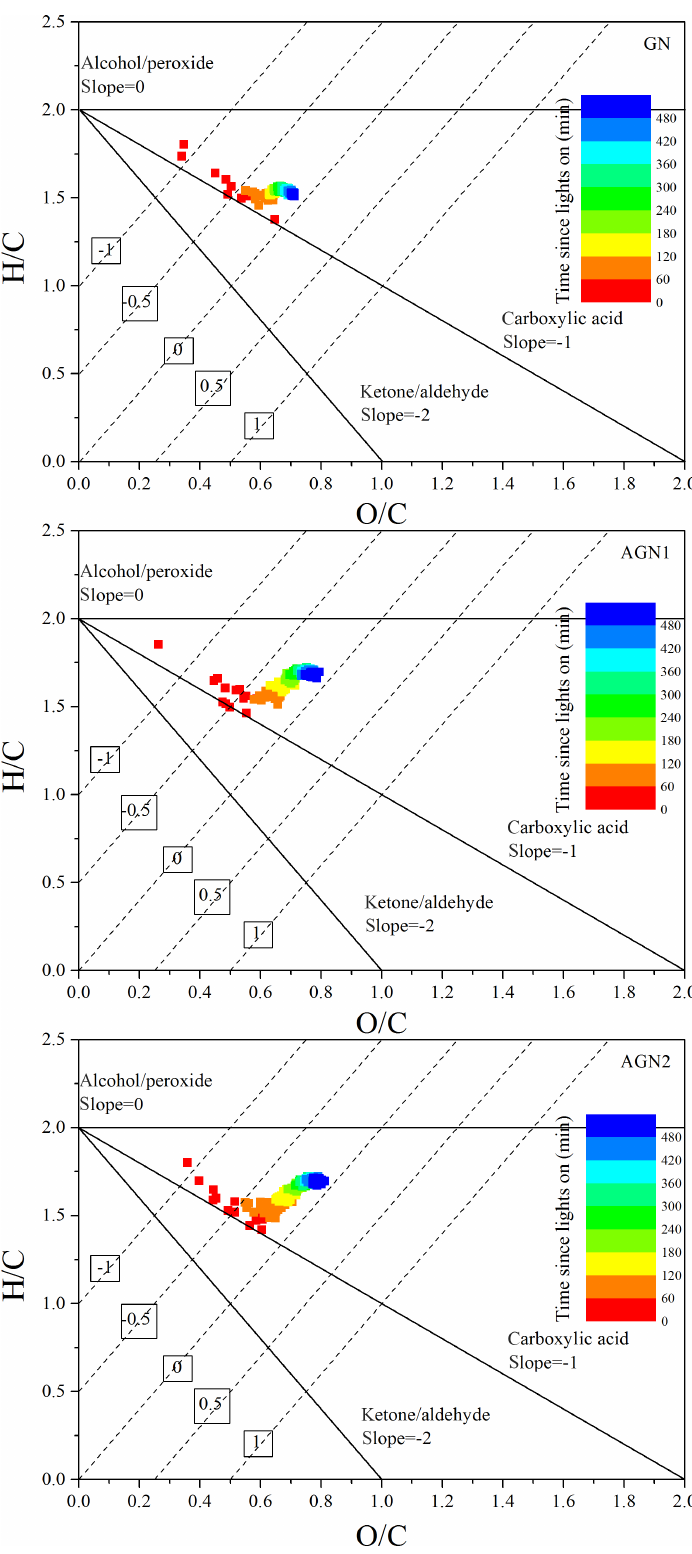
Figure 7. Time evolution of H / C and O / C in SOA formed from the photo-oxidation of gasoline vapor at different concentrations of NH 3 (Exp. GN, AGN1, and AGN2). The numbers (i.e., − 1, − 0 . 5, 0, 0.5, and 1) labeling the dashed lines show the average carbon oxidation state (OSc = 2 × O / C − H / C) (Kroll et al., 2011). The black lines represent the addition of functional groups to an aliphatic carbon (Heald et al.,